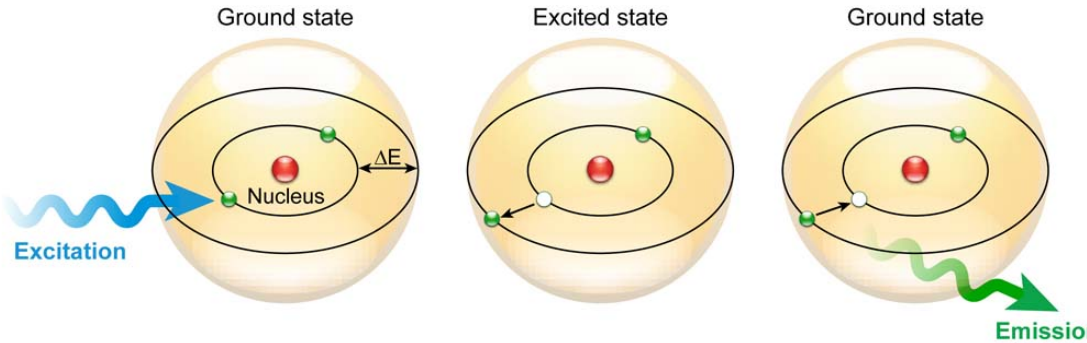
Figure 1. Fluorescence principle. Schematic representation of the fluorescence phenomenon in the classical Bohr model. Absorption of a light quantum (blue) causes an electron to move to a higher energy orbit. After residing in this “excited state” for a particular time, the fluorescence lifetime, the electron falls back to its original orbit and the fluorochrome dissipates the excess energy by emitting a photon